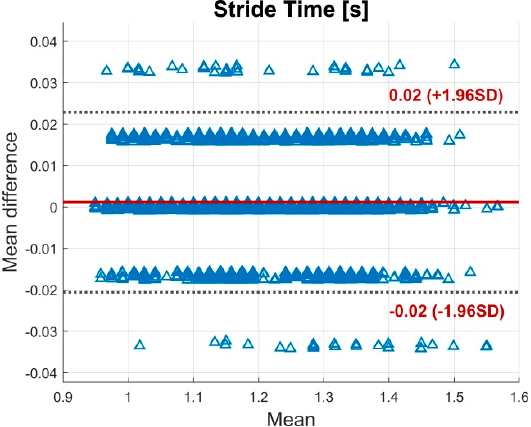
Figure A9. BA plot for the stride time. The plot contains all calculated data points of all subjects. The solid line indicates the mean difference. The dashed lines indicate the LoA (95% CI of the mean difference).